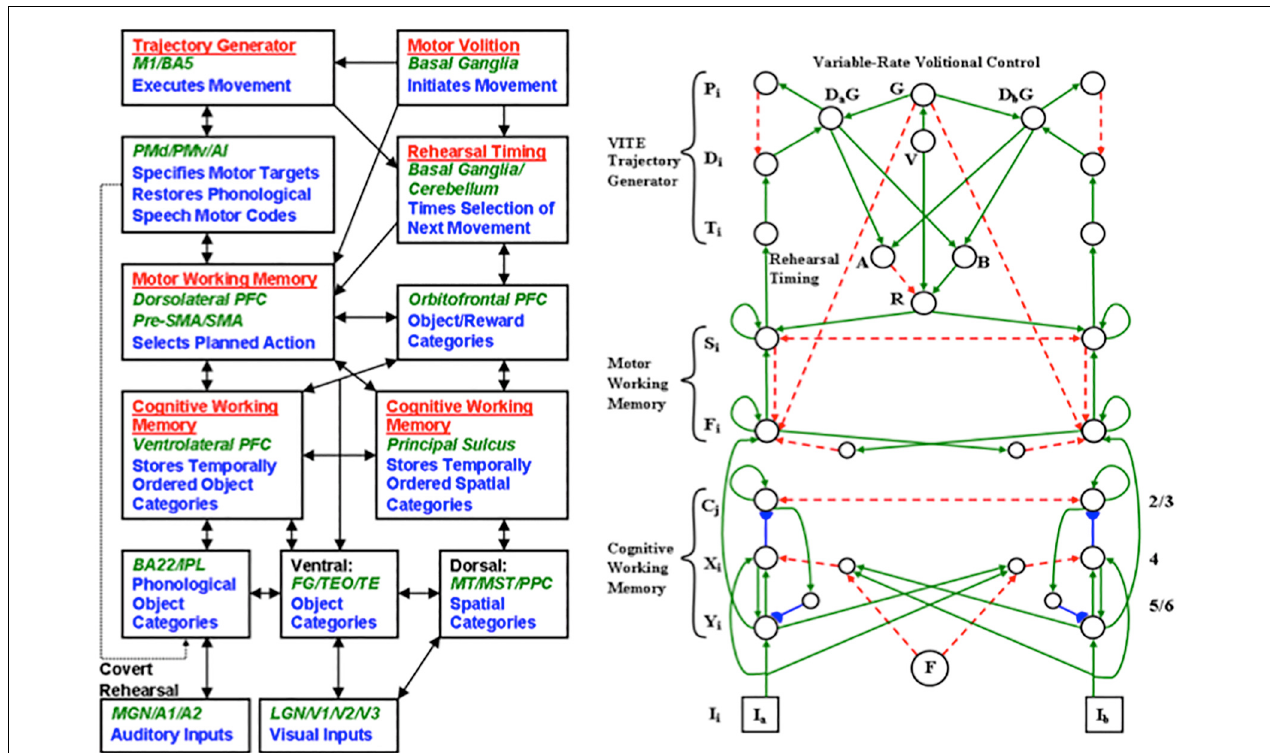
FIGURE 6 | (left panel) The LIST PARSE laminar cortical model of working memory and list chunking includes circuits to model the brain regions that are marked in red. (right panel) The model’s Cognitive Working Memory circuit is proposed to occur in ventrolateral prefrontal cortex. The Motor Working Memory, VITE Trajectory Generator, and Variable-Rate Volitional Control circuits model how other brain regions, such as dorsolateral prefrontal cortex, motor cortex, cerebellum, and basal ganglia, interact with the Cognitive Working Memory to control working memory storage and volitional control of variable-rate performance of item sequences. [Adapted with permission from Grossberg and Pearson